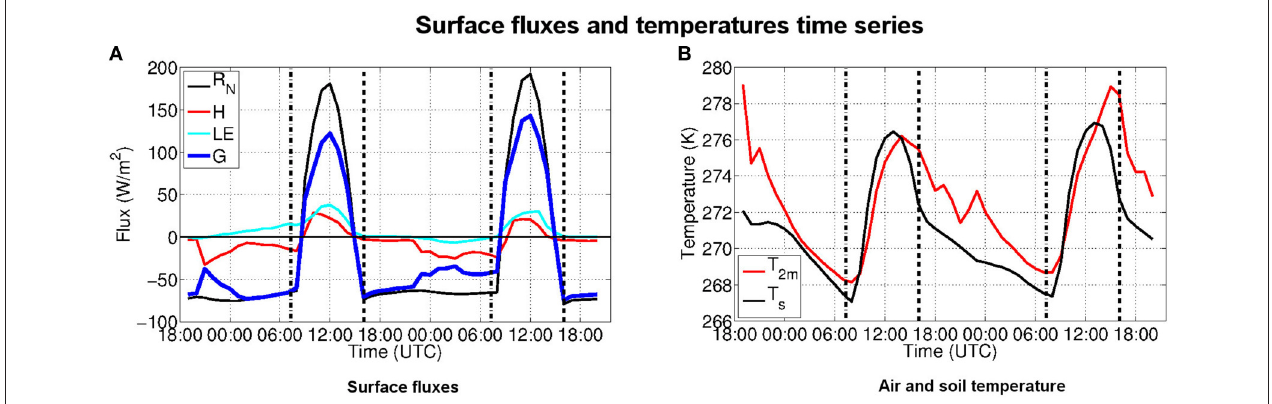
FIGURE 9 | (A) Temporal evolution of the surface fluxes R N , H , LE , G = R N − H − LE from 27 December, 18:00 UTC to 29 December, 20:00 UTC in the Grésivaudan valley at point Gr displayed in Figure 7A . The vertical dashed lines are the astronomical sunset and sunrise times for Grenoble. (B) Temporal evolution of the surface temperature ( T s ) and the 2- m air temperature ( T 2 m